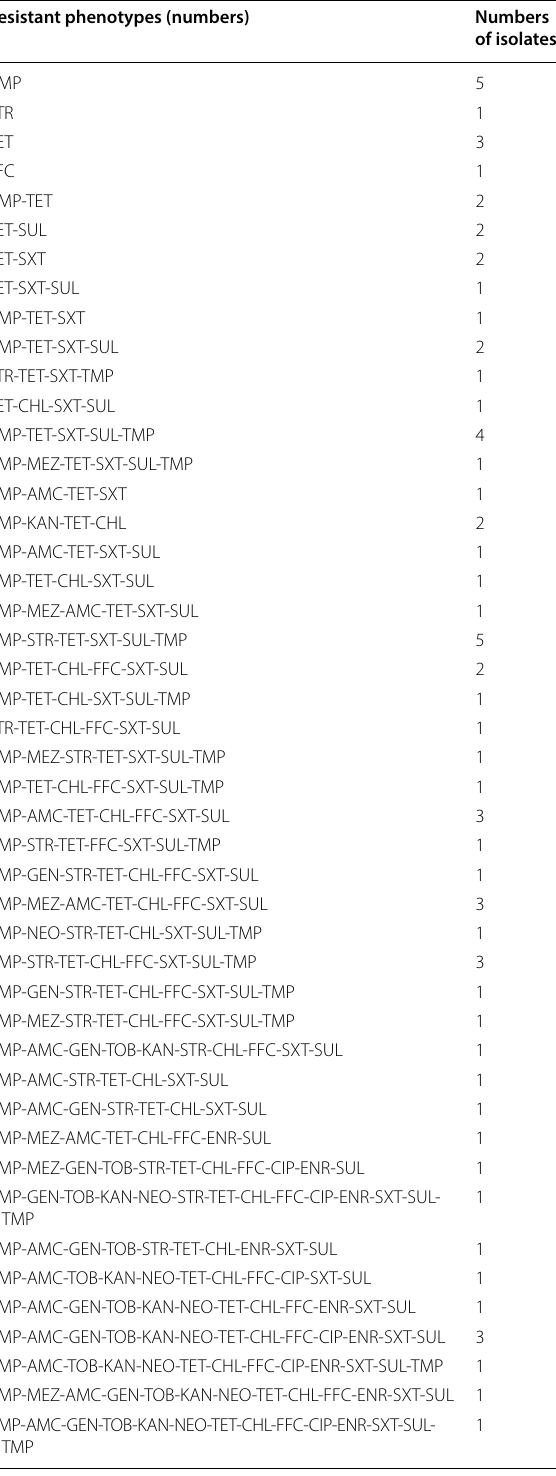
Table 4 Antimicrobial resistance rates of the 80 Table 5 Antimicrobial resistance phenotypes of the 80 Salmonella